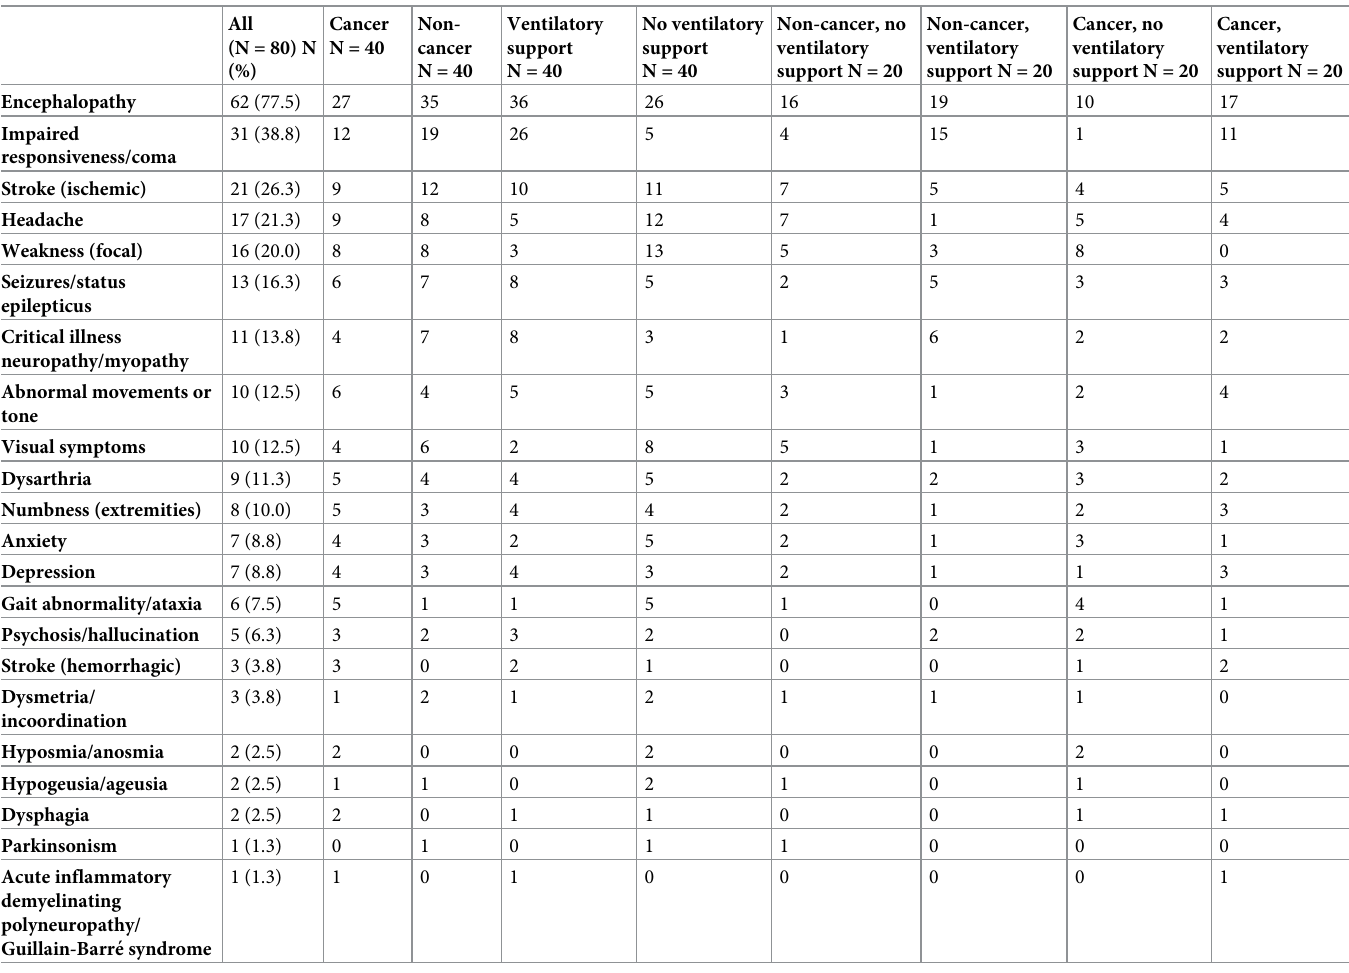
Table 1. Neurological manifestation listed by highest to lowest